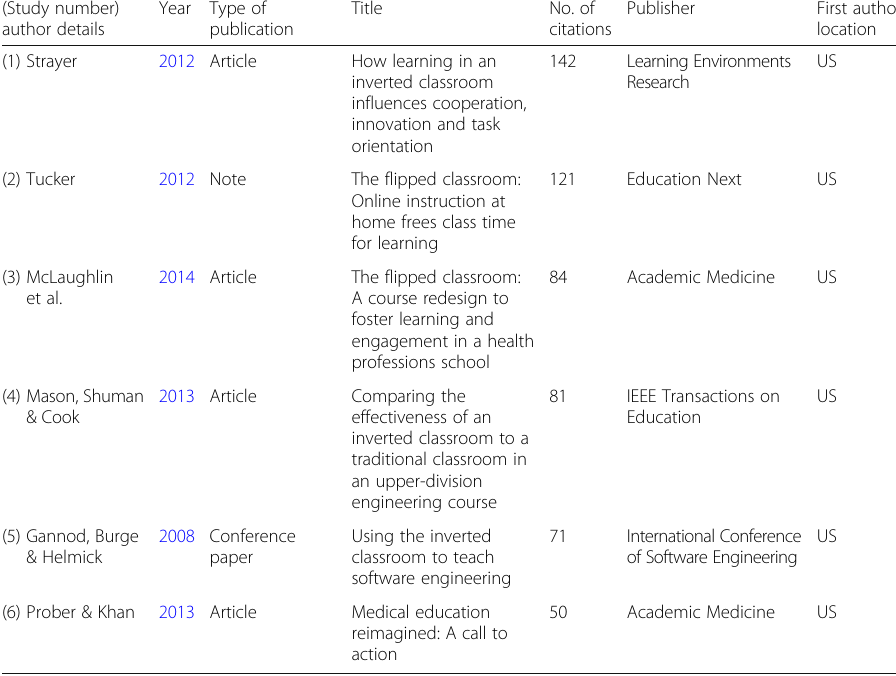
Table 2 Location, publication type, publication source ’ s impact factor and number of citations of the 6 most-cited publications in the field of flipped